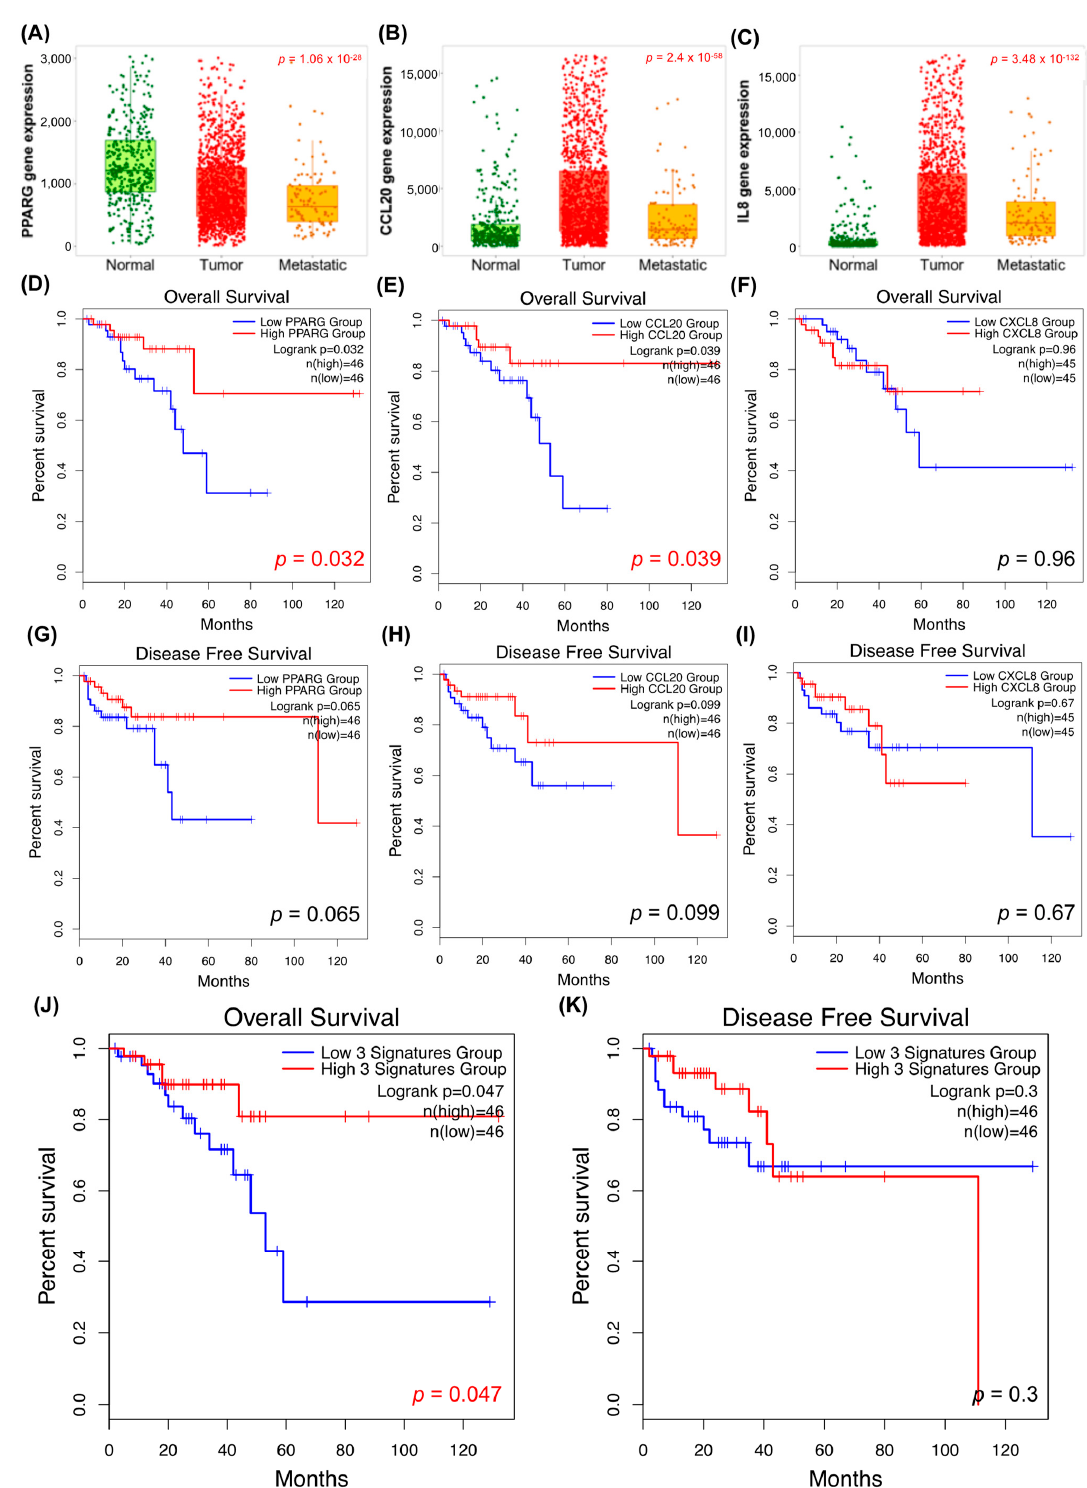
Figure 5. Analysis of PPARG ( A ), CCL20 ( B ) and CXCL8 ( C ) gene expression in normal, tumour and metastatic colon tissue. Overall survival and disease-free survival analysis of colorectal cancer patients based on GEPIA data. Kaplan–Meier survival analysis comparing high and low mRNA expression of PPARG ( D ), CCL20 ( E ), CXCL8 ( F ) and these three combined ( J ) regarding their associations with overall survival. Kaplan–Meier survival analysis comparing high and low mRNA expression of PPARG ( G ), CCL20 ( H ), CXCL8 ( I ) and these three combined ( K ) regarding their associations with disease-free